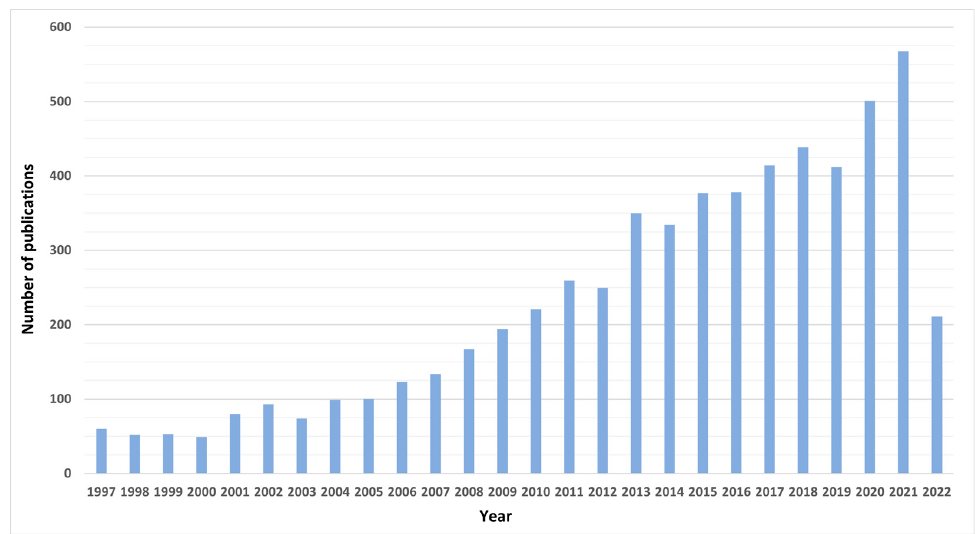
Figure 1. Number of publications in SciFinder from 1997 to first half of